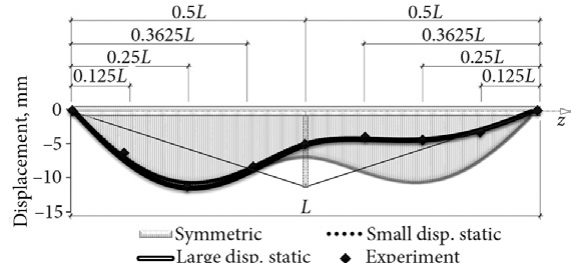
Fig. 8. Results of the UGB deformational response under Test